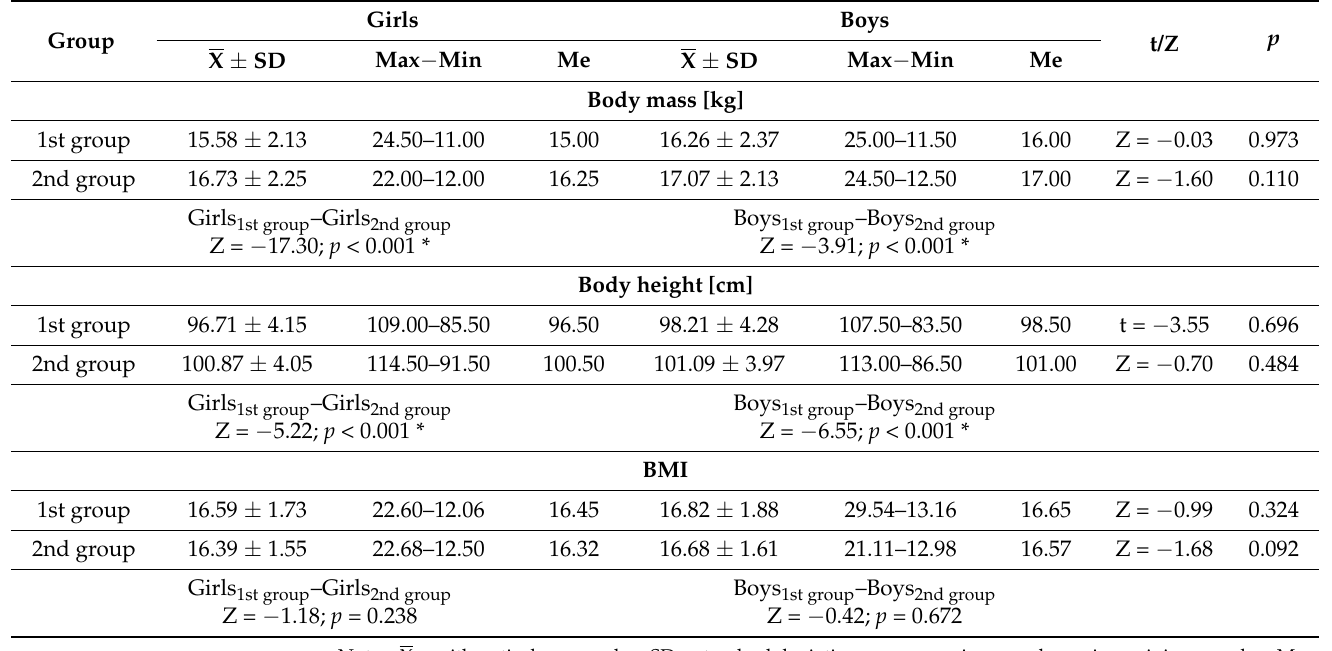
Table 2. The somatic features of the examined